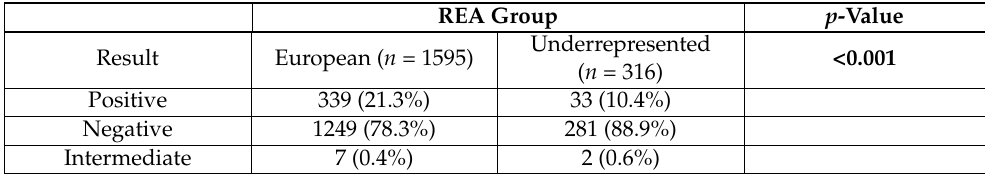
Table 3. Identification of the C9orf72 HRE in European and underrepresented REA.